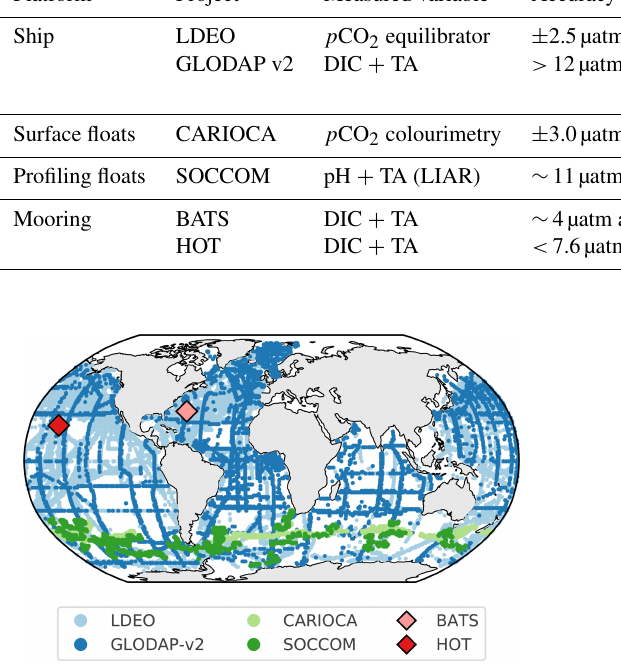
Figure 4. The distribution of the validation data. Details of these datasets are given in Table 2. The Hawaii ocean time series (HOT) and the Bermuda Atlantic time series (BATS) are marked as dia- monds to distinguish them as time series